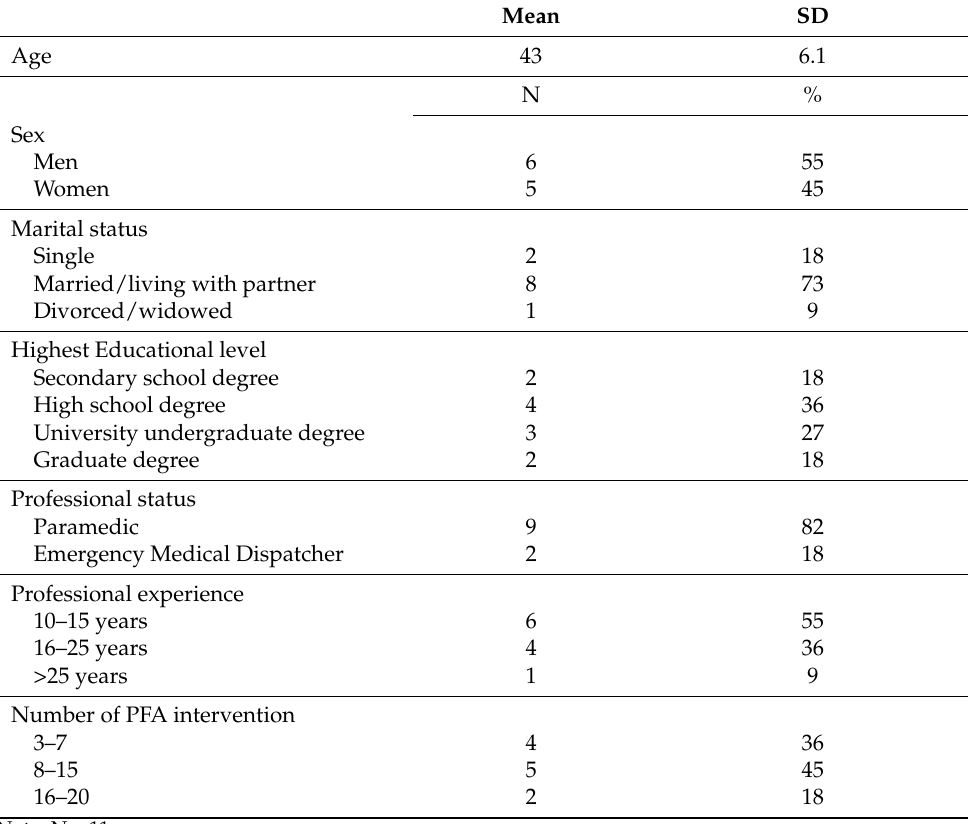
Table 1. Participant demographic and professional